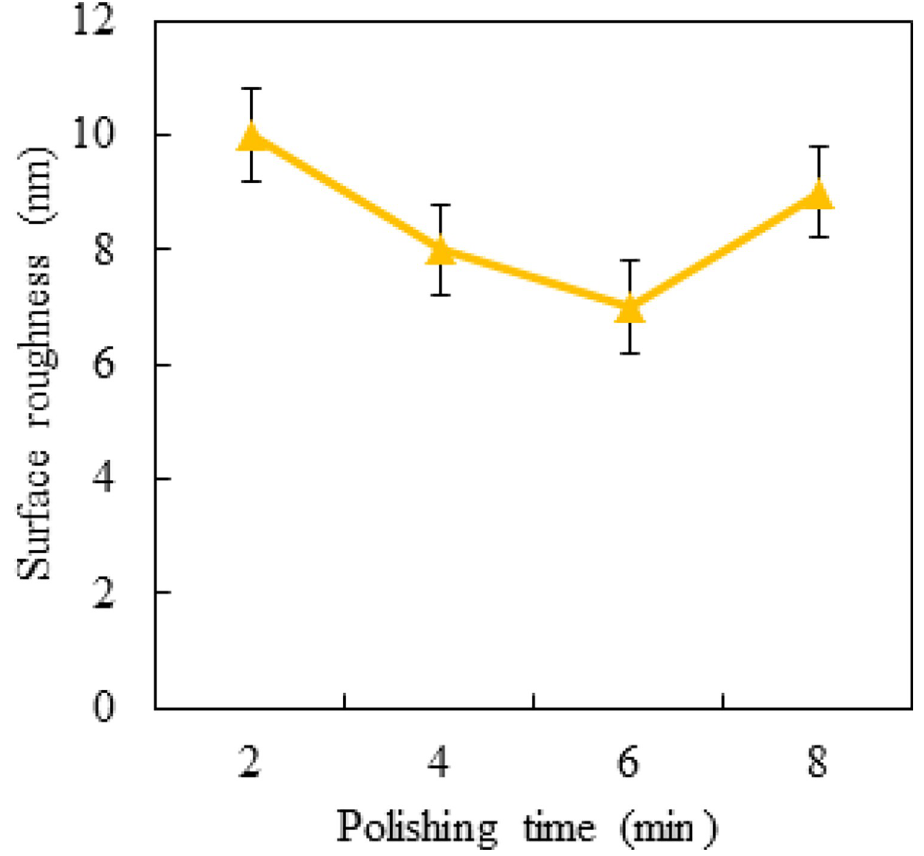
Fig 9. Effect of polishing time on